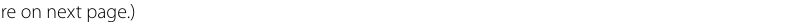
figure on next Fig. 6 Transcription profiles of the differentially expressed genes between the OsCBM1 ‑transgenic plants and the wild type (WT). A Comparison of expression patterns of differentially expressed genes identified between the WT (Nipponbare) and OsCBM1 ‑RNAi transgenic plant RNAi54. The leaves of six‑week‑old plants of OsCBM1‑RNAi54 and the WT grown in plastic pots filled with paddy soil were used for the transcriptional analysis. The red dots represent upregulated genes, whereas the blue dots represent downregulated genes in the RNAi54 plants as compared to that of the WT. B Significantly enriched GO categories of the differentially expressed genes. Results are summarized in three categories: biological process, cellular component, and molecular function. C Transcriptional expression profiles of several protein family genes under both normal growth and drought stress conditions. The transcripts of the selected genes were analyzed by qRT‑PCR with OsActin1 as the internal control. Error bars indicate SD from three replicates and the bars annotated with different letters represent values that are significantly different ( p one‑way